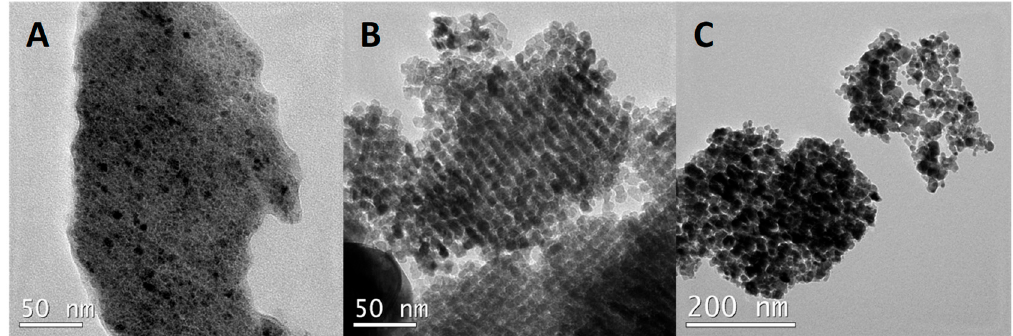
Figure 2. Representative transmission electron microscopy (TEM) images of di ff erent nickel containing samples: ( A ) NiCOM, ( B ) NiO precursor of NiNC, and ( C )